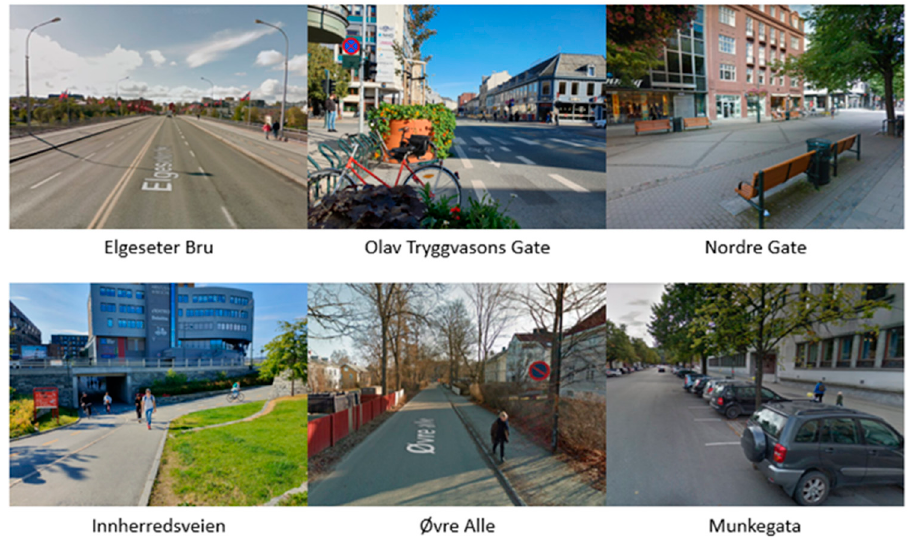
Figure 1. Pictures of the measurement points.